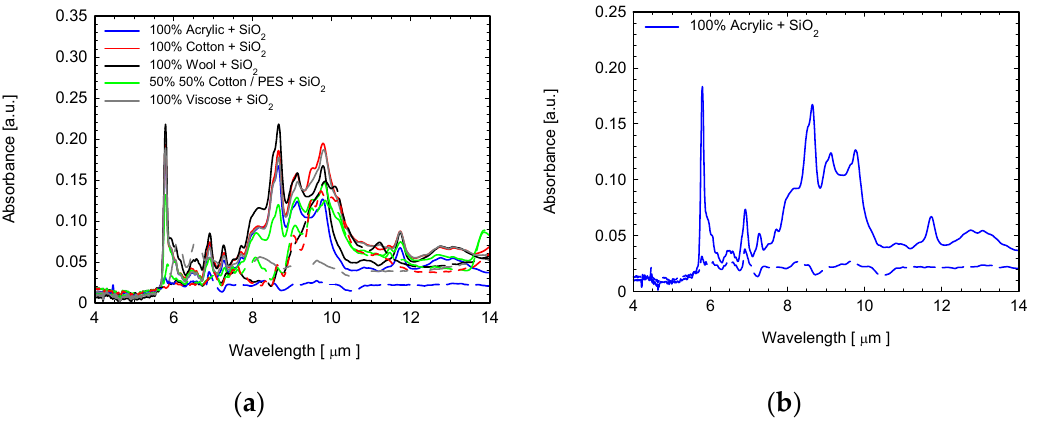
Figure 10. ( a ) ATR-FTIR spectra of investigated fabrics coated with SiO 2 (solid lines) and uncoated (dashed lines) in the range 4–14 μ m; ( b ) detailed comparison between coated (solid line) and uncoated (dotted line) acrylic fabrics.